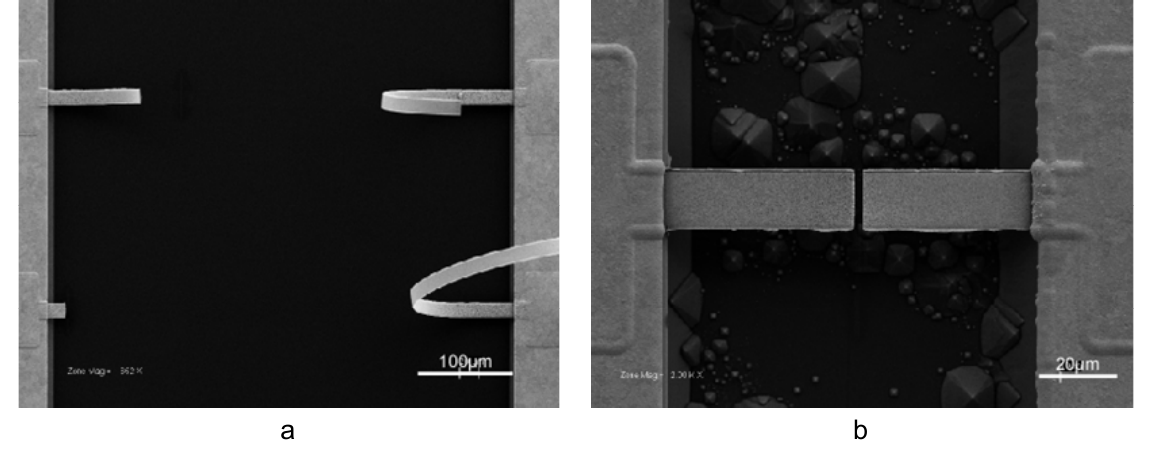
Figure 5. (a) When Au-Ag cantilevers are dealloyed, they warp significantly. (b) np-Au cantilevers can be produced by cutting np-Au beams with focused ion beam.